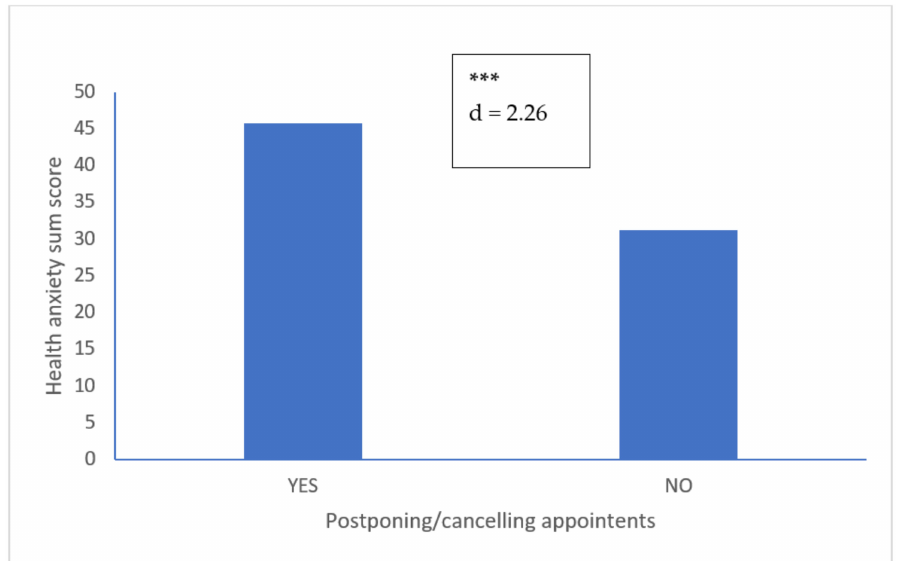
Figure 1. Health anxiety scores of participants who did ( n = 57) and who did not ( n = 46) postpone or cancel routine medical appointments. Notes: *** = p < 0.001; d = Cohen’s d: Large e ff ect